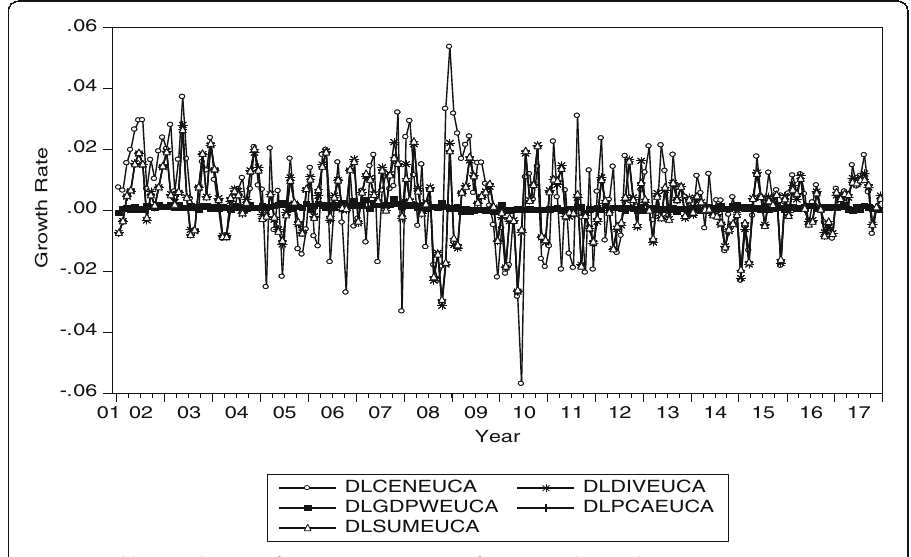
Fig. 2 Monthly Growth Rates of Monetary Aggregates of Europe and Central Asia. DLCENEUCA, DLDIVEUCA, DLGDPWEUCA, DLPCAEUCA and DLSUMEUCA are log differences of CE, Divisia index, GDP- weighted, PCA-based, and Simple-Sum measures for Europe and Central Asia respectively. The numbers 01 through 17 on the horizontal axis represent the years 2001 through 2017